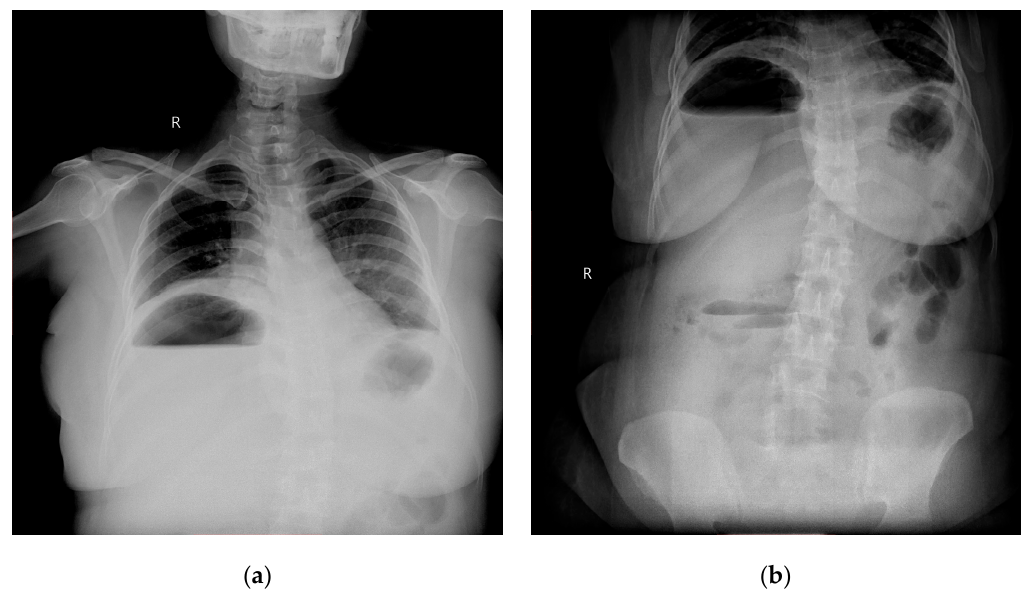
Figure 1. ( a ) Chest roentogram showing air fluid level in the right upper abdomen; ( b ) abdominal radiogram showing air fluid level in right upper with some fluid levels in central abdomen as well.